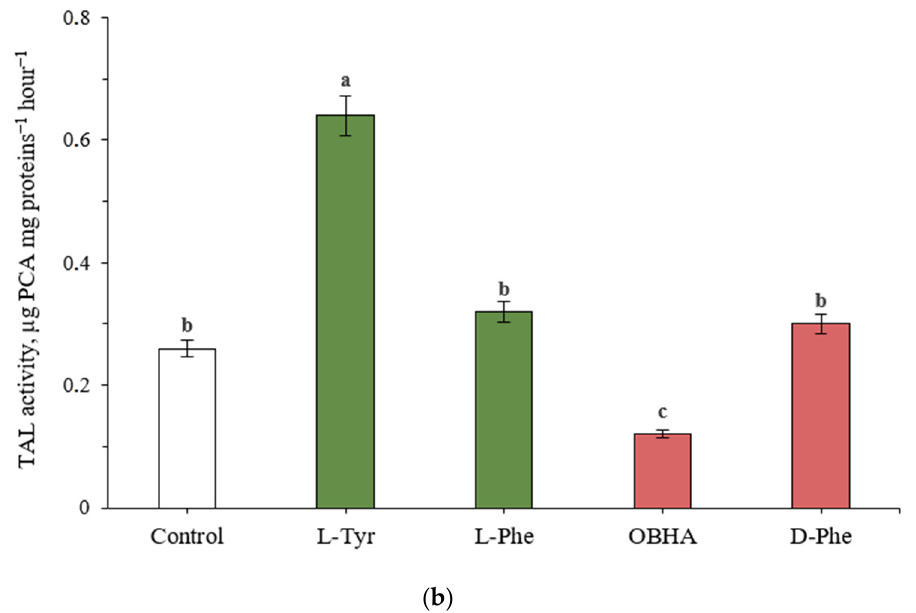
Figure 1. Activity of PAL ( a ) and TAL ( b ) in wheat samples incubated on a nutrient medium supplemented with 500 µ M of active compounds. Bars marked with different letters show significant differences at ( p ≤ 0.05) according to Tukey’s test.